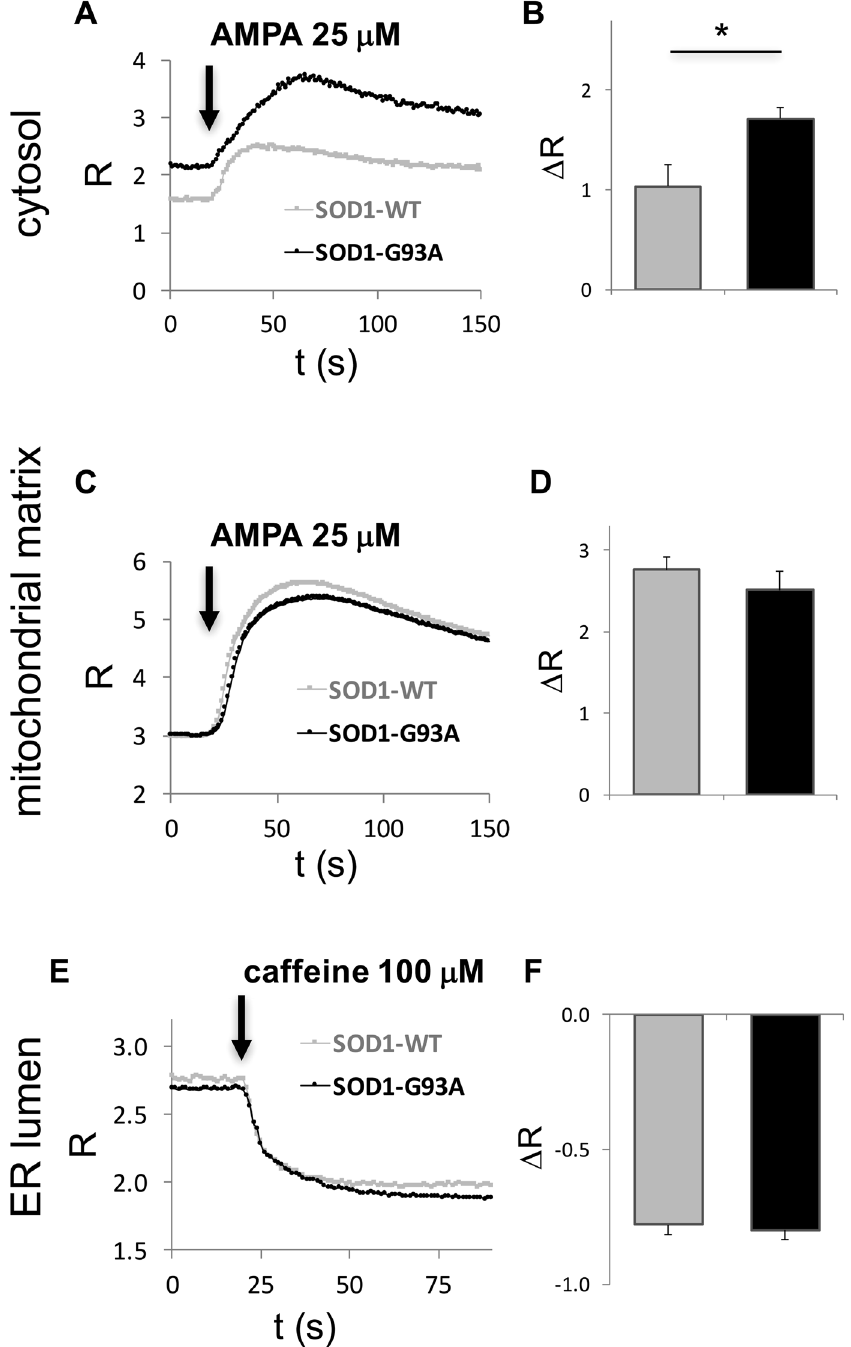
Figure 4. AMPA stimulation results in higher cytosolic Ca 2 + transients in primary spinal cord MNs from ALS mice than in the healthy counterpart. Primary spinal cord cultures from hSOD1(WT) or hSOD1(G93A) mice were transduced with the AAV vectors coding for the cameleon probes targeted to the cytosol (panels A,B), the mitochondrial matrix (panels C,D) or the ER lumen (panels E,F). After 12 days of culturing, FRET measurements were performed on single MNs expressing the different Ca 2 + probes using a computer-assisted fluorescence microscope equipped with a suitable system for double-wavelength recordings. The ratio (R) between the FRET acceptor and donor was calculated by the data acquisition software, allowing the comparison of Ca 2 + mobilisation following stimulation with AMPA (25 μ M in the presence of 2 mM CaCl 2 , for the cytosol and the mitochondrial matrix) or caffeine (100 μ M, for the ER) at the time-points indicated by arrows, between hSOD1(WT) or hSOD1(G93A) MNs. Panels A, C, E report average traces of the Ca 2 + dynamics (for the sake of clarity, error bars are not reported), while bar diagrams of panels B,D,F report the mean difference between FRET ratios ( Δ R = R peak − R baseline ) following the indicated stimulus in the three cell compartments. While no difference was recorded in Ca 2 + movements in the mitochondrial matrix or the ER lumen, the cameleon- based approach highlighted a significantly higher Ca 2 + response following AMPA stimulation in the